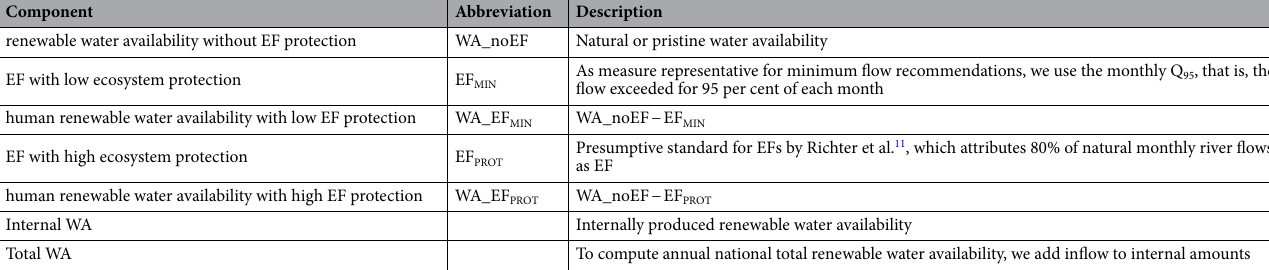
Table 1. Different water balance components used in this study.